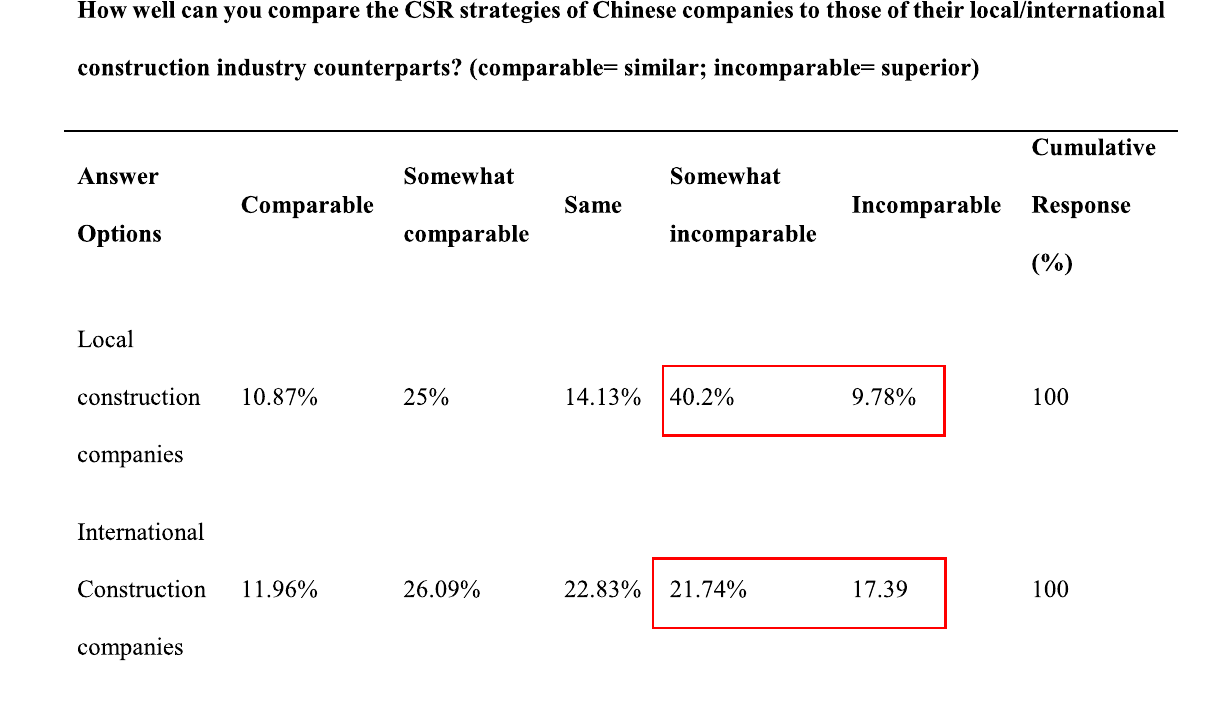
Table 2 Comparison of CICCs, local and international firms regarding